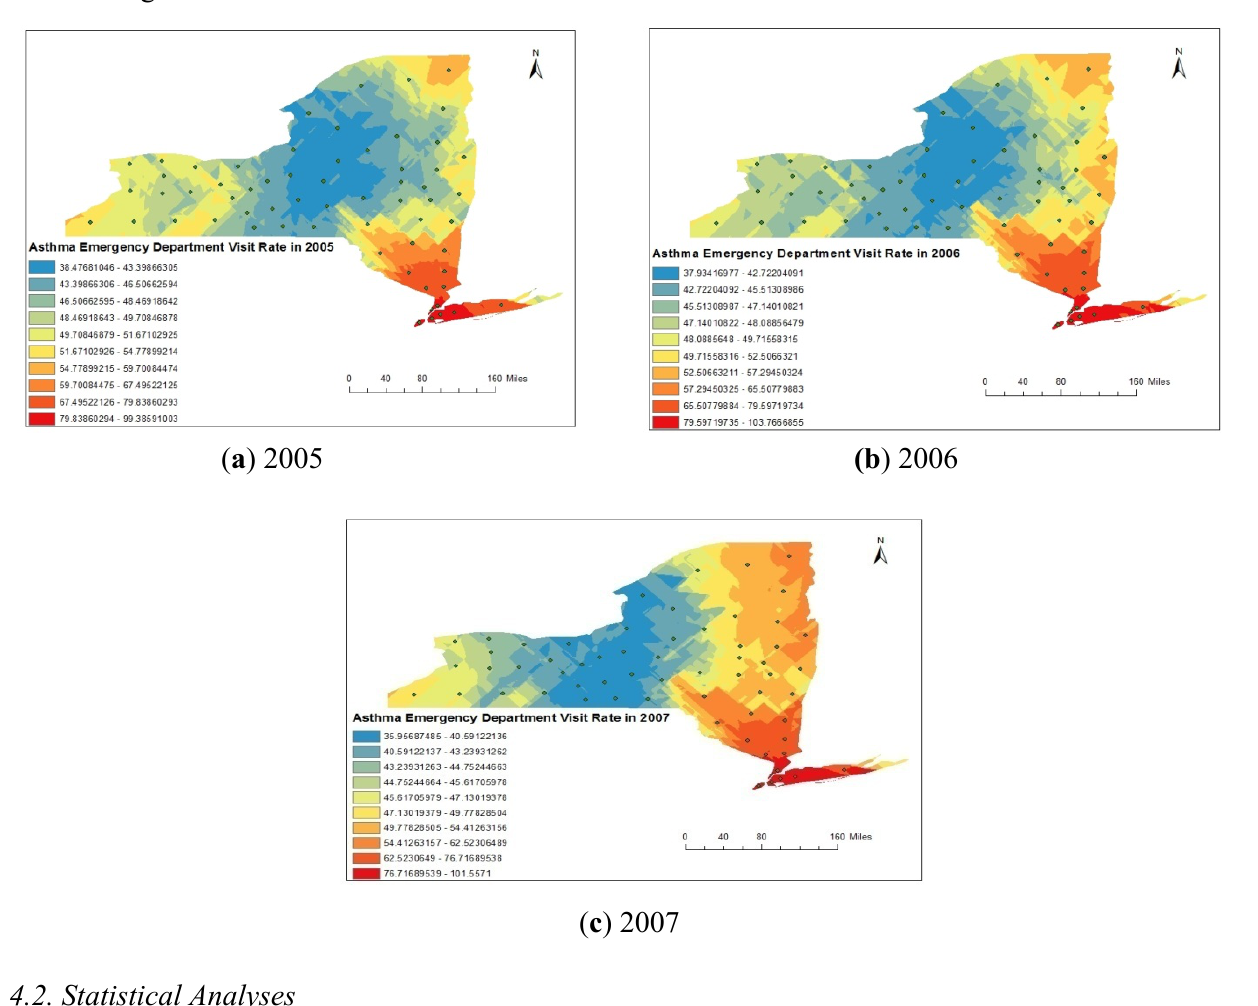
Figure 9. ( a – c ). Spatial distribution of asthma emergency department visit rate (AEVR) during 2005 to